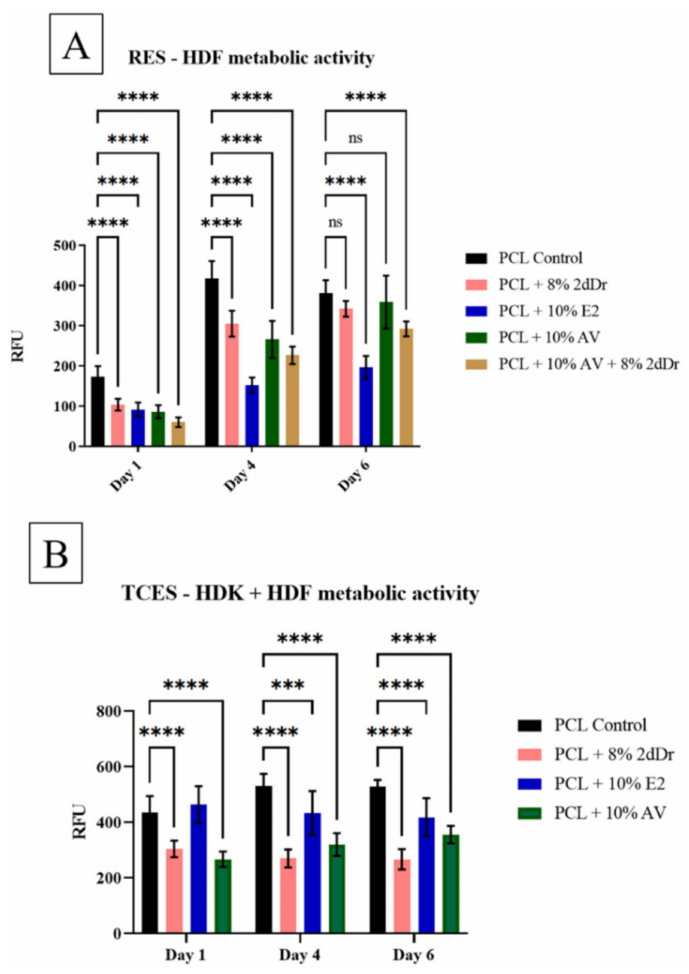
Figure 6. Cell metabolic activity of ( A ) HDF seeded on PCL RES loaded with different bioactive compounds and ( B ) HDF + HDK seeded on PCL TCES loaded with 2dDr, E2, or AV. *** p < 0.001, **** p < 0.0001. N = 2, n =